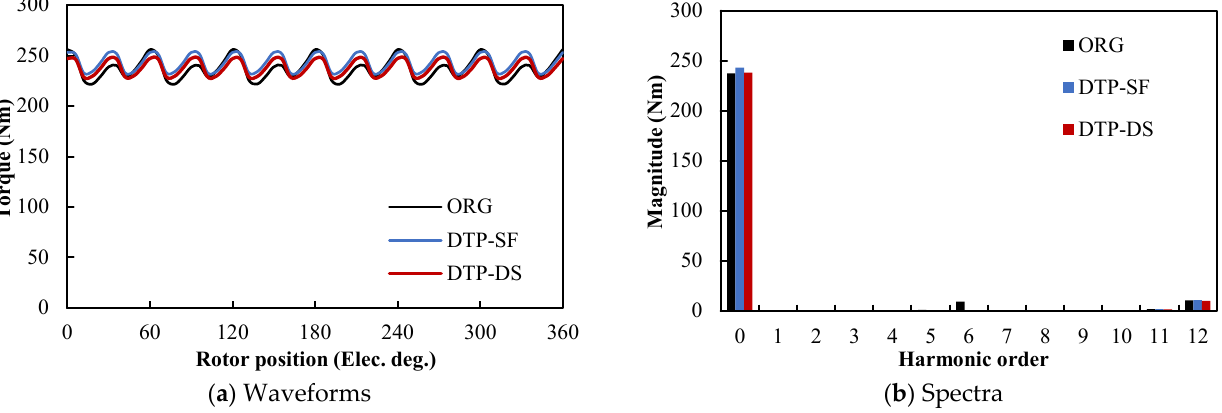
Rotor position (Elec. deg.)